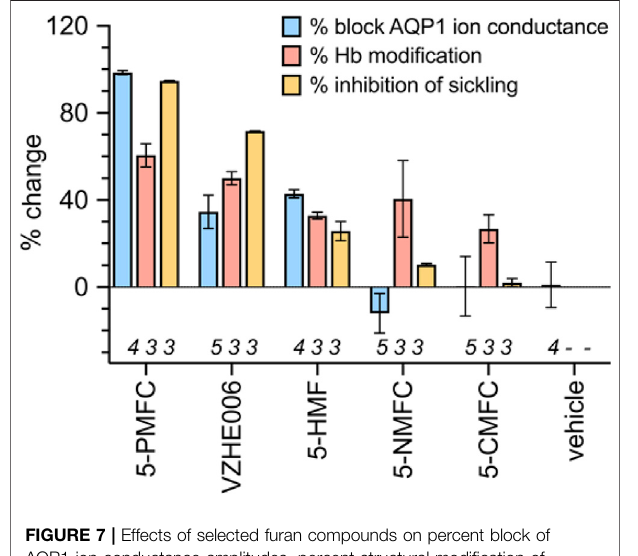
FIGURE 7 | Effects of selected furan compounds on percent block of AQP1 ion conductance amplitudes, percent structural modi fi cation of hemoglobin (Hb), and percent inhibition of sickling in SCD red blood cells exposed to low oxygen. Tests of AQP1 block were done with agents at 0.5 mMeach;testsforhemoglobinmodi fi cationandsicklingriskweredoneat 2 mM each. Data for Hb modi fi cation and red blood cell sickling were based on results presented in published tables (Xu et al., 2017).